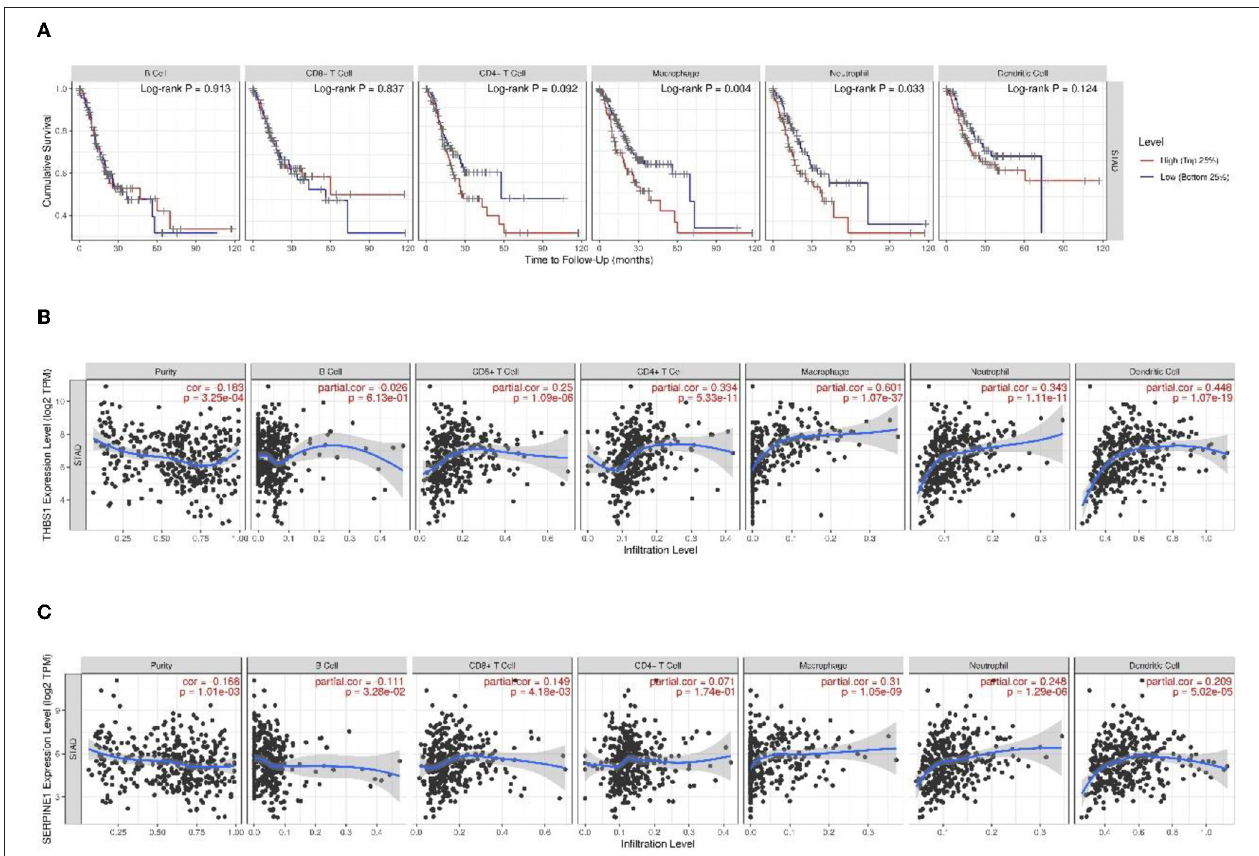
FIGURE 12 | (A) Kaplan–Meier curves of gastric cancer stratified by immune cell abundance. Correlation with levels of immune infiltration (purity, B cells, CD8 + T cells, CD4 + T cells, macrophages, neutrophils, and dendritic cells) for (B) THBS1 and (C) SERPINE1. The correlation measurement is indicated by the partial correlation value using Spearman’s partial rho and the statistical significance of the p